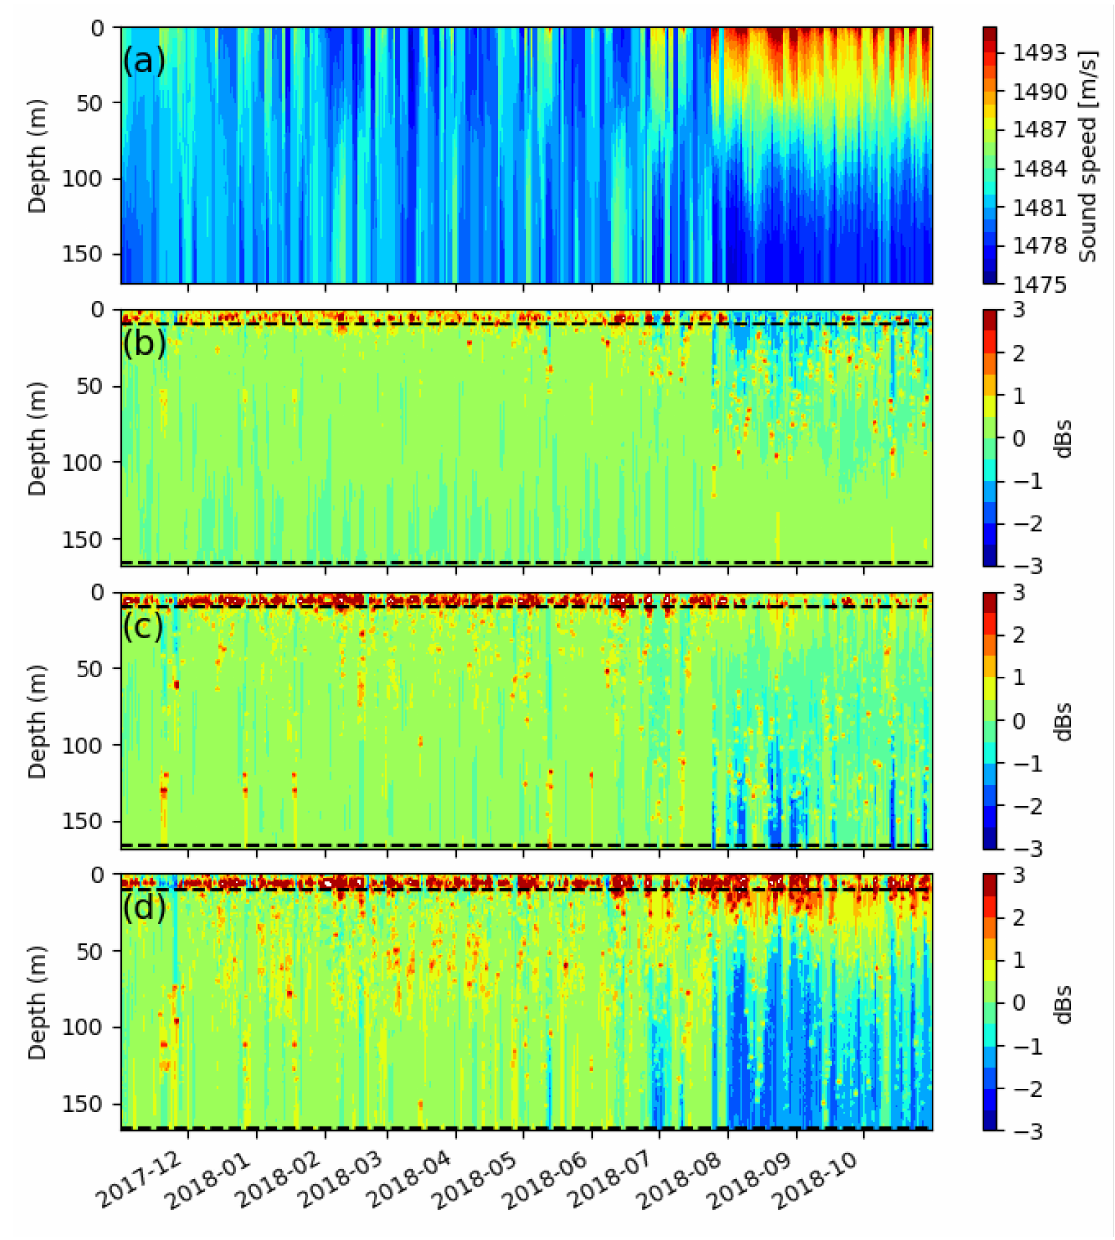
Figure 9. ( a ) SalishSeaCast-model-derived sound speed profiles; ( b ) six hourly modeled TL minus the 12-month median values when the source-to-receiver distance was 1000 m; ( c ) same for when the distance was 2000 m; and ( d ) when the distance was 3000 m. The dashed horizontal lines indicate the depths of 10 m and 161 m from which the TL variabilities are shown in Figure